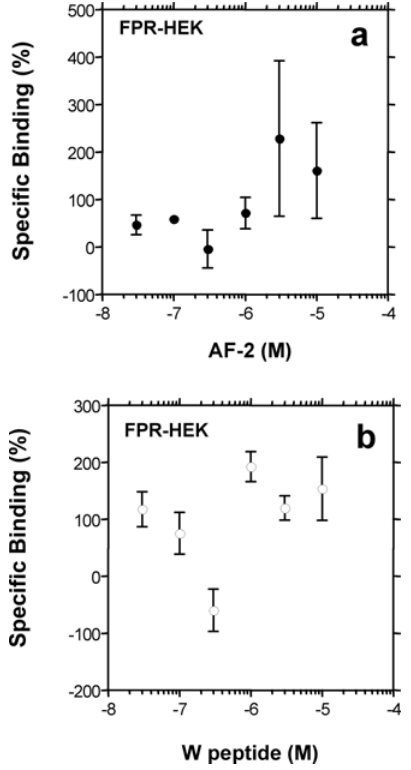
FIGURE 2. Lack of competition binding with AF-2 and W-peptide ligands to FPR HEK cells. Lack of displacement of the [ 125 I-Tyr]-Ac2-26 tracer by AF-2 (a) and W peptide (b) on FPR-HEK cells. Data presented as mean ± SEM of four independent